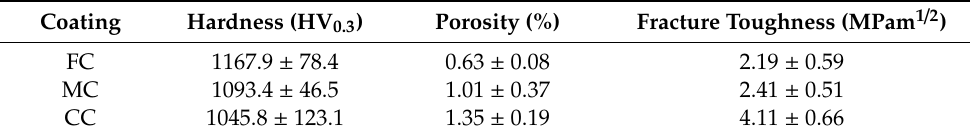
Table 3. Properties of the three WC-20Cr 3 C 2 -7Ni coatings.